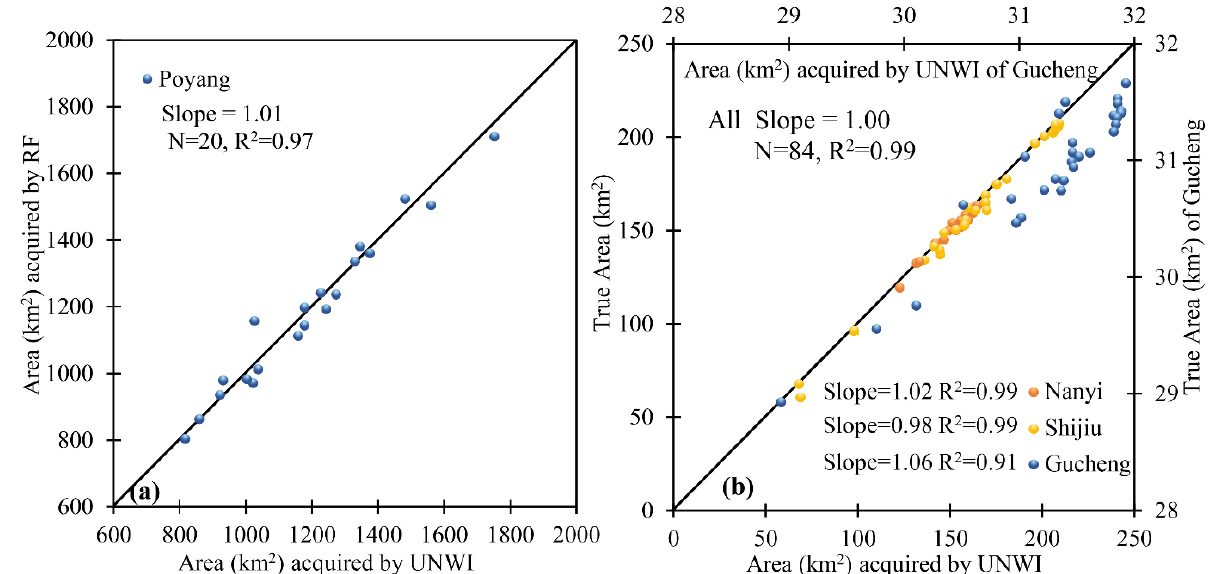
Figure 13. ( a ) Comparisons of Landsat water inundation area of Poyang lake through UNWI method and RF classification [29] ( b ) and results of Sentinel-2 images of Nanyi (29 in number), Shijiu (26 in number), and Gucheng (29 in number) Lakes (note, the black line represents the 1:1 line). The 21-year inundation frequencies and records of 184 lakes in the EPL are